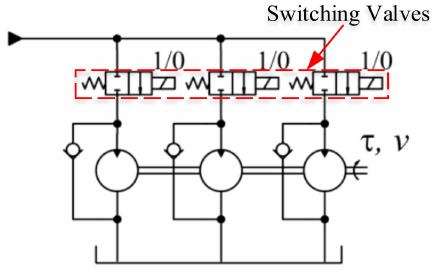
Figure 17. Parallel digital hydraulic